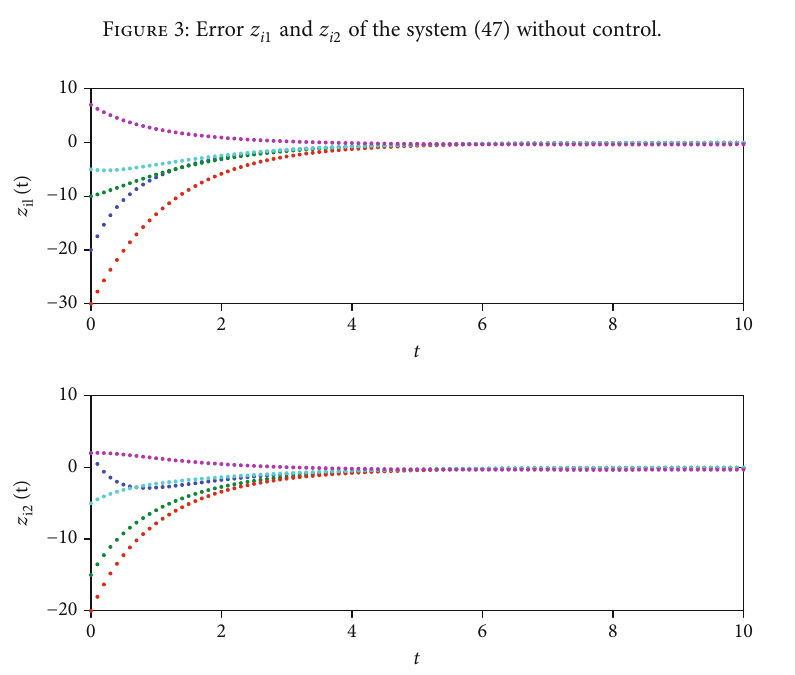
Figure 4: Synchronization error z